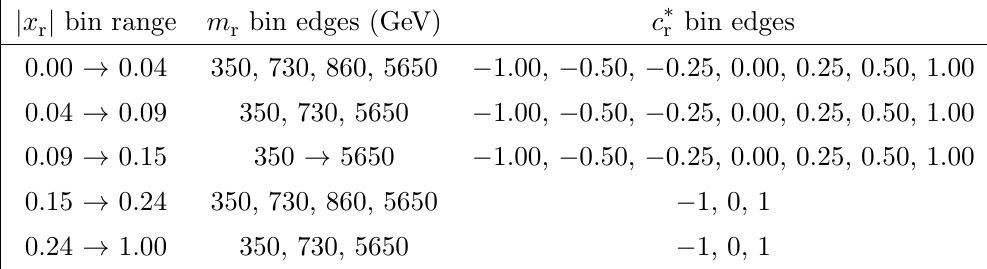
Table 5 . Template binning in the type-2 m +jets signal regions (each template has 46 total bins).